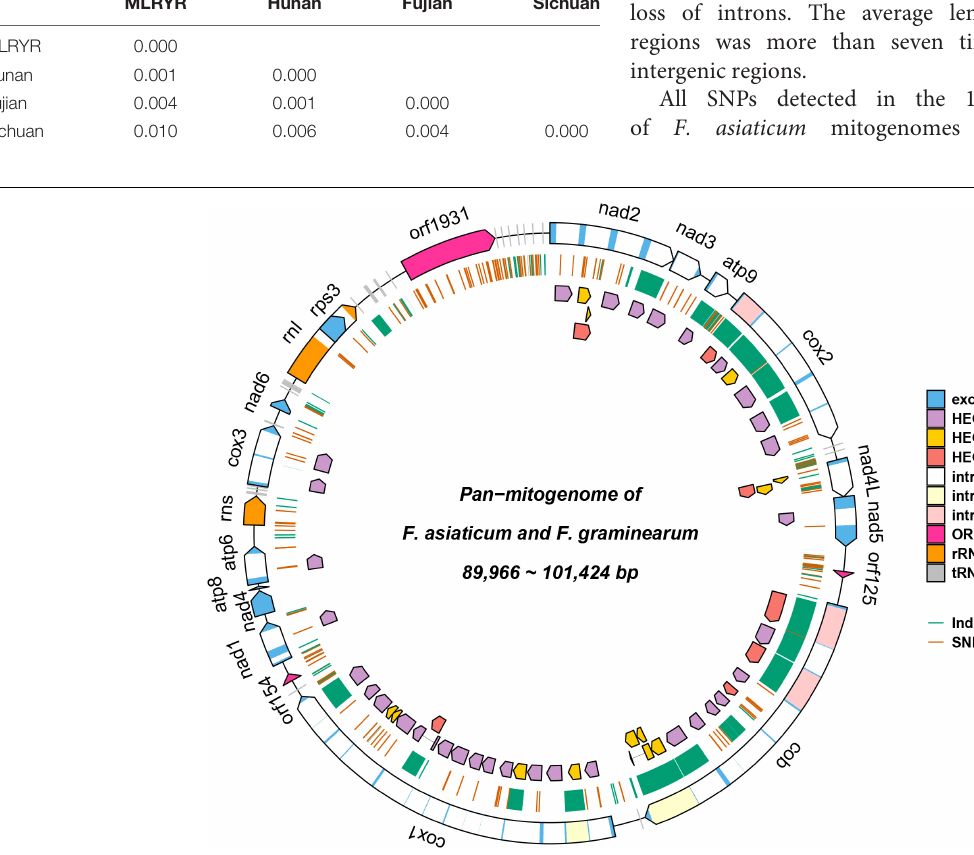
Frontiers in Microbiology |